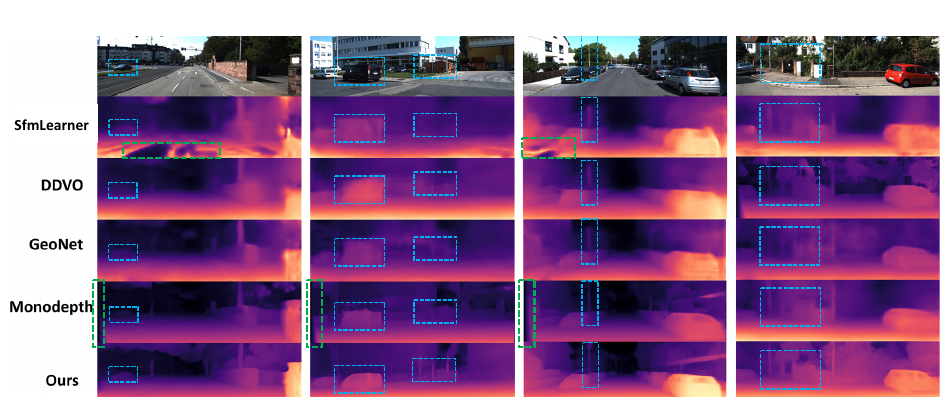
Figure 4. Qualitative KITTI results. Our method is compared with the results of SfmLearner [10], DDVO [17], GeoNet [11] and Monodepth [9]. The higher intensity of red in the picture, the closer the distance. The results in the blue dashed boxes are the areas we focus on. The results in the green dashed boxes are “holes” in the depth